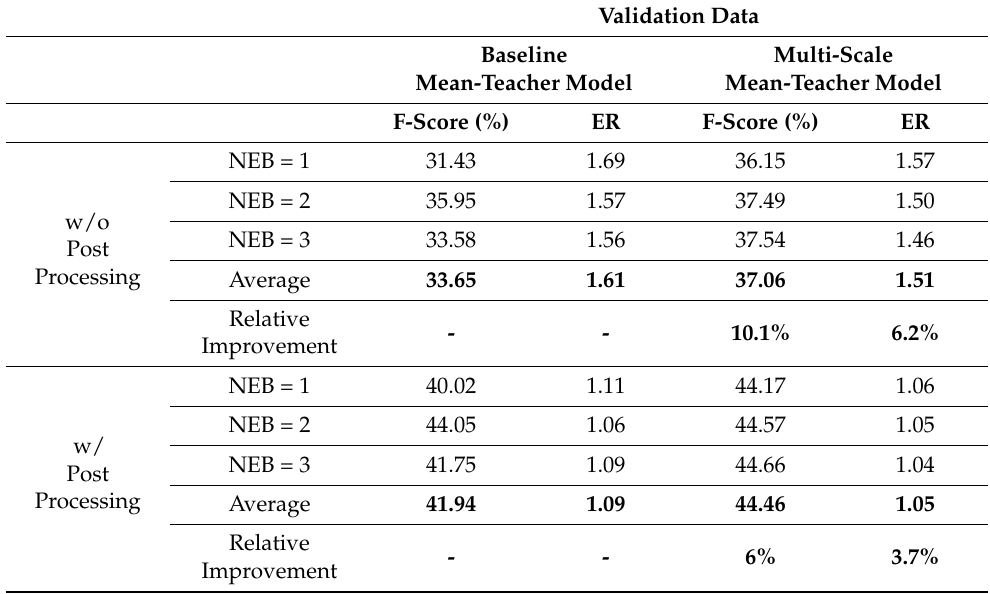
Table 5. Comparison of event-based SED results on validation data between baseline mean-teacher model and the proposed mean-teacher model with multi-scale features.